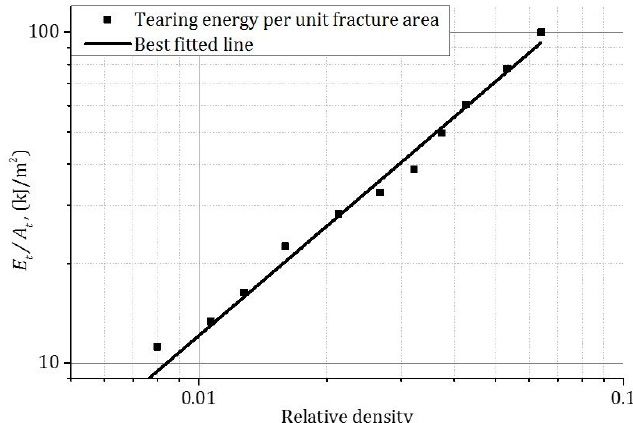
Figure 6. The relationship between the tearing energy per unit fracture area and relative density of honeycomb at a strain rate of 1 × 10 3 s − 1 .